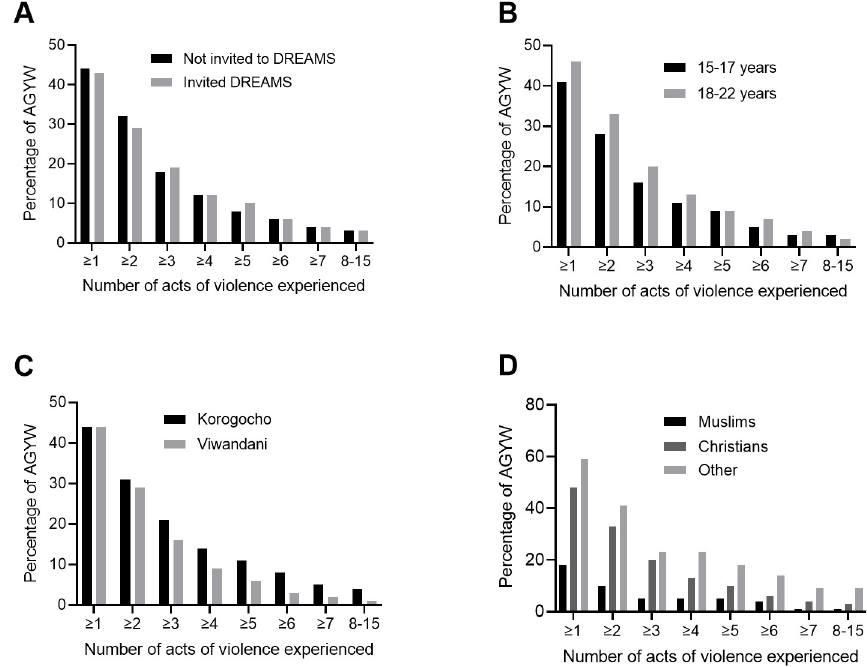
Fig 2. DREAMS survey data: Percentage of AGYW who experienced one or more violence acts, two or more acts, three or more acts, and so on up to 8 or more acts of violence, stratified by invitation to participate in DREAMS (A), age (B), site (C) and religion